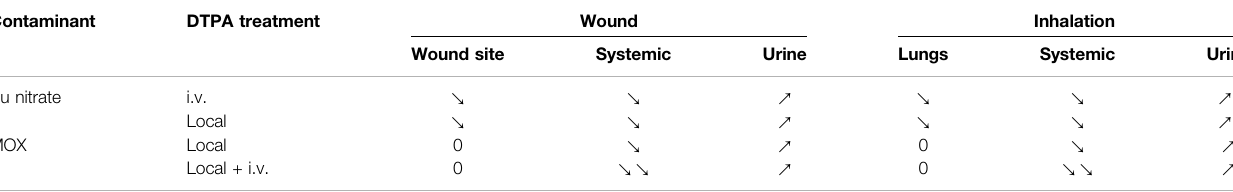
TABLE 4 | Comparative ef fi cacy of two different DTPA treatment protocols on tissue levels and urinary excretion of activity.